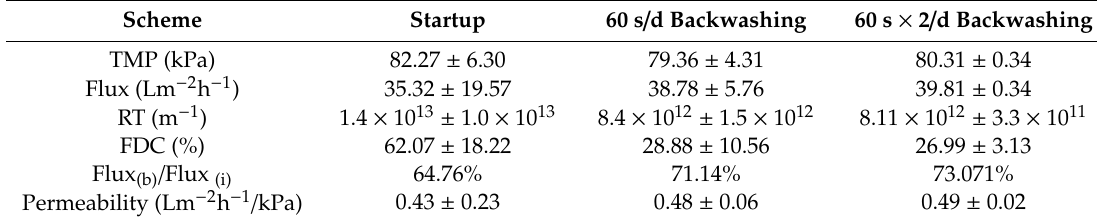
Table 2. The membrane filtration performance during three